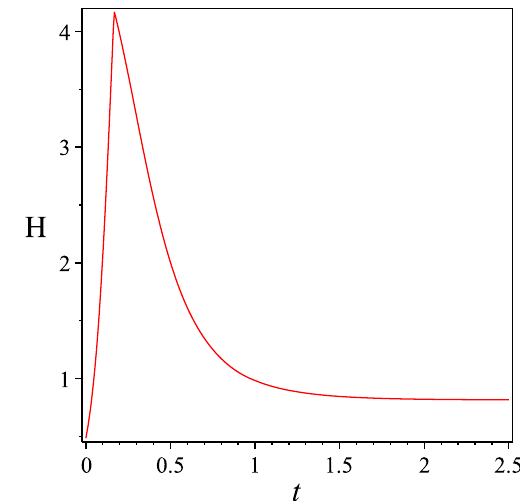
Fig. 1 The Hubble parameter H ( t ) is plotted against t